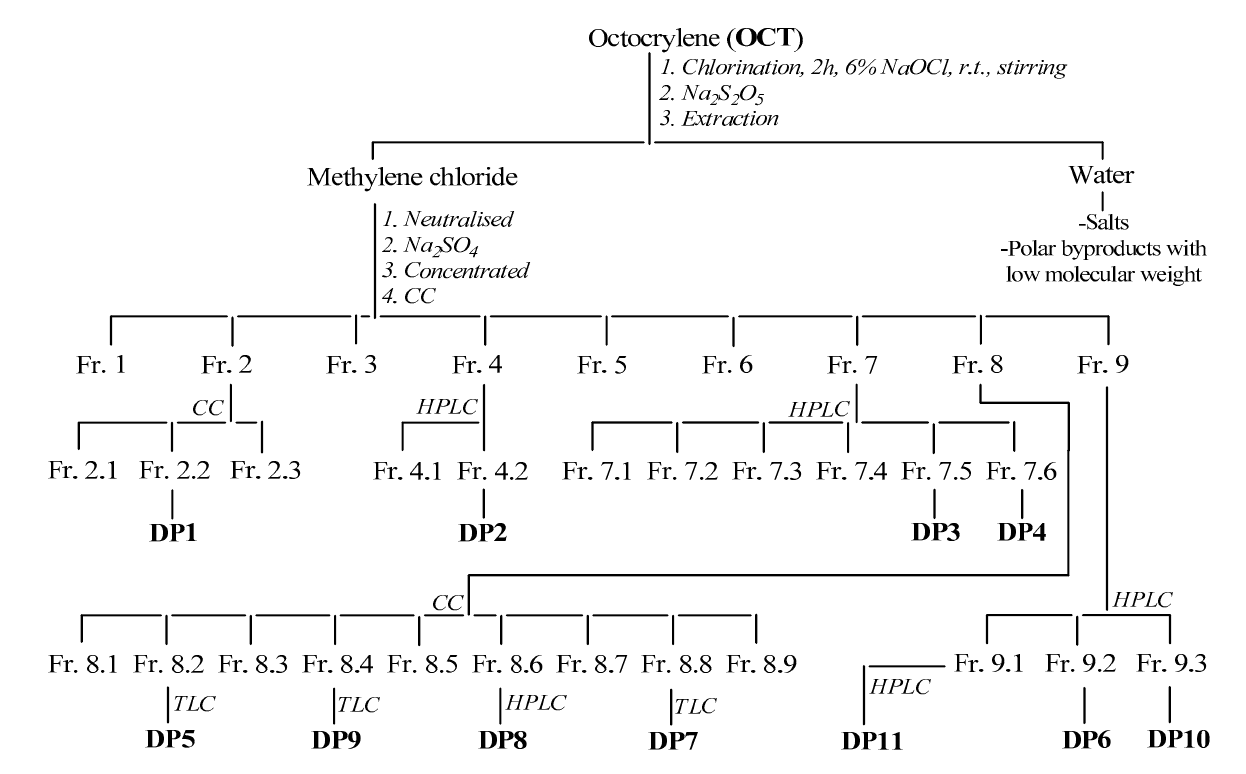
Scheme 1. The isolation of the degradation byproducts.